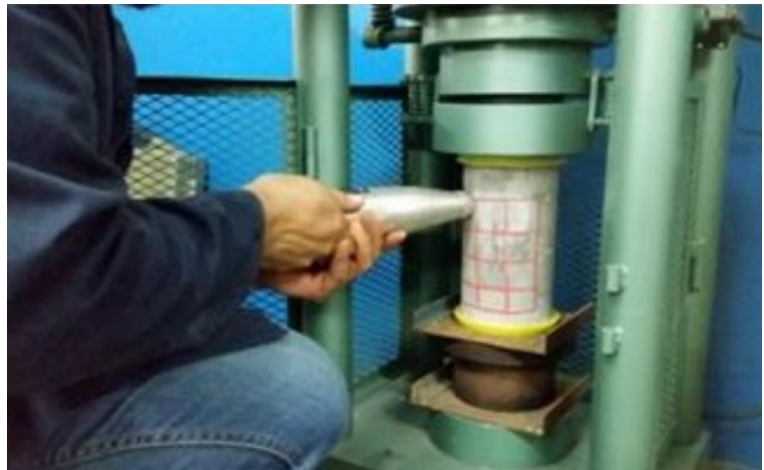
Figure 3. Rebound Number test.